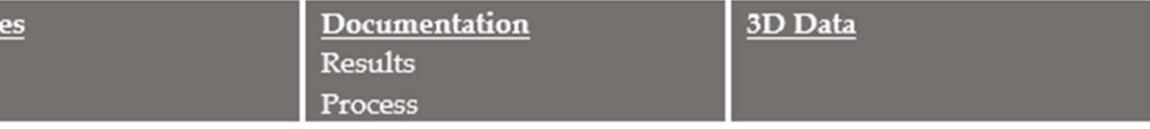
Figure 16. Chapter